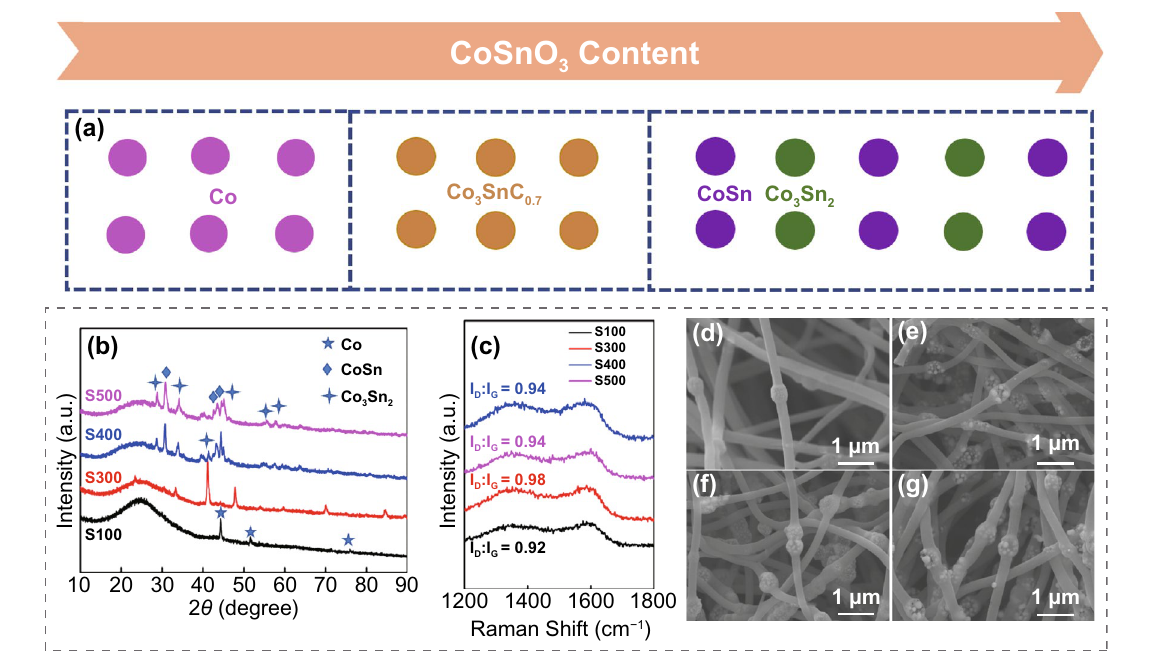
Fig. 8 The relationship between CoSnO 3 doping amount and final products phase transition ( a ); the XRD ( b ) and Raman ( c ) spectrums of S100, S300, S400, S500; the SEM images of S100 ( d ), S300 ( e ), S400 ( f ), S500 ( g )